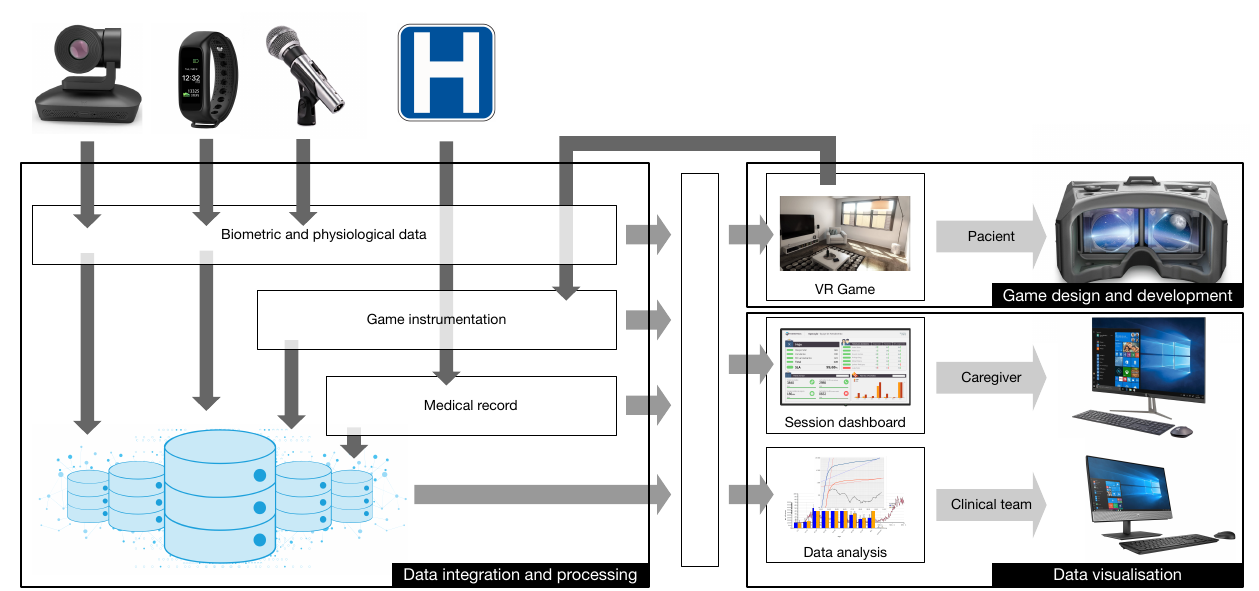
Figure 2. System